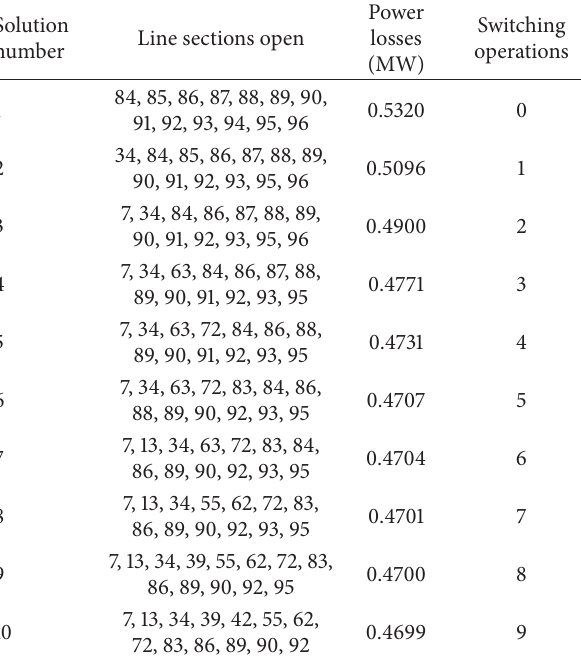
Table 1: Characteristics of the approximate Pareto-optimal solu- tions in Figure